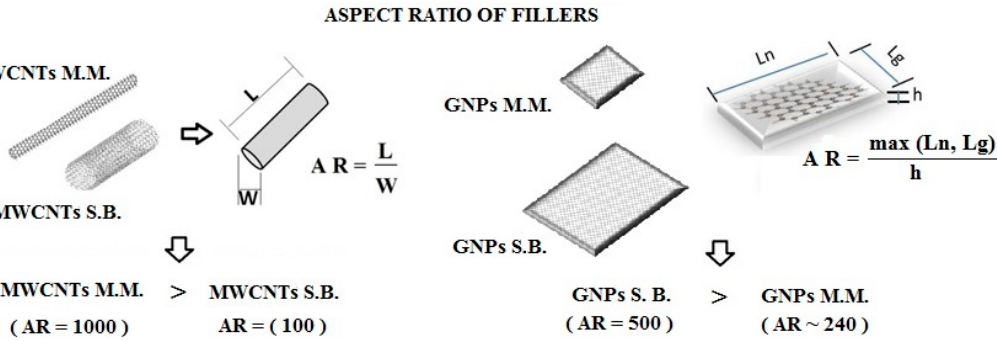
Figure 4. Different aspect ratio of the adopted fillers.